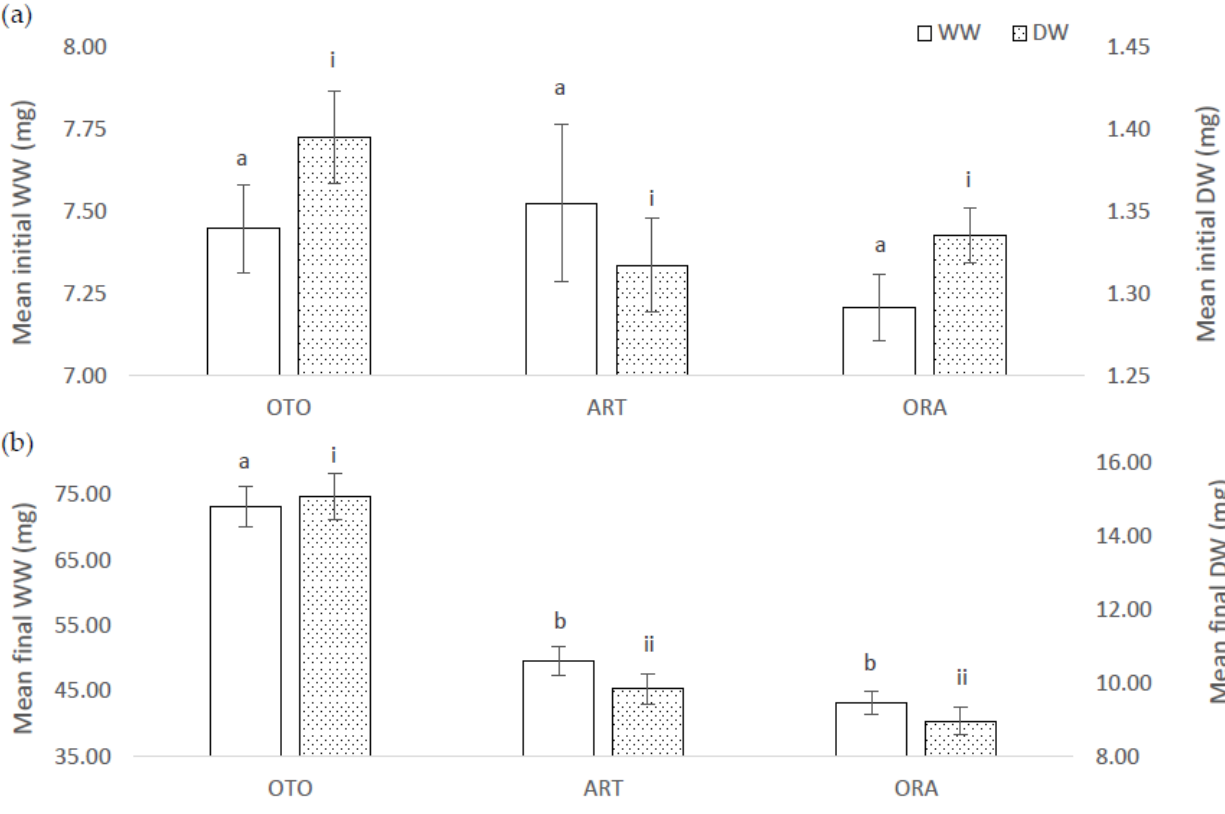
Figure 1. ( a ) Mean initial wet weight (WW) and dry weight (DW) for larval giant kōkopu from three different feed treatments; OTO (Otohime), ART (Artemac) and ORA (O.range) (mean ± SE). Means with different superscripts are significantly different among treatments for WW and among treatment for DW ( p < 0.05). ( b ) Mean final wet weight (WW) and dry weight (DW) for larval giant kōkopu from three different feed treatments; OTO (Otohime), Artemac (ART) and ORA (O.range) (mean ± SE). Means with different superscripts are significantly different among treatments for WW and among treatment for DW ( p < 0.05).